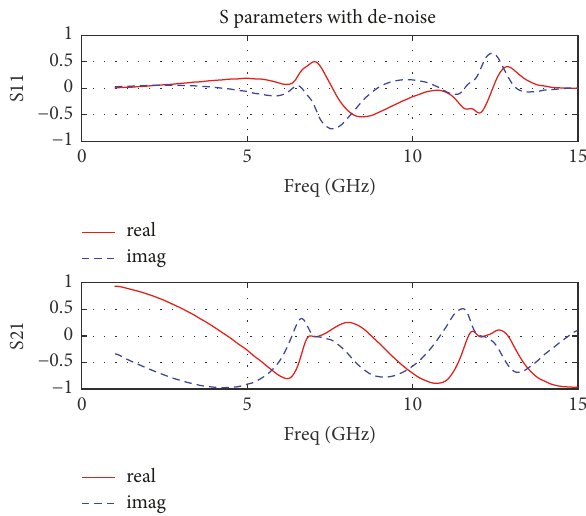
Figure 7: The S11 and S21 signals with noise removed.